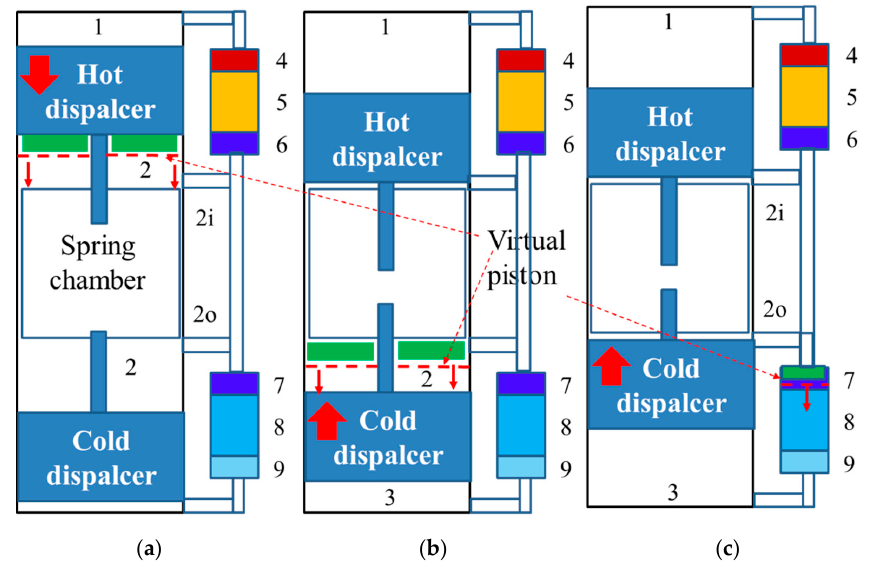
Figure 5. Schematic of Vuilleumier model with virtual piston.